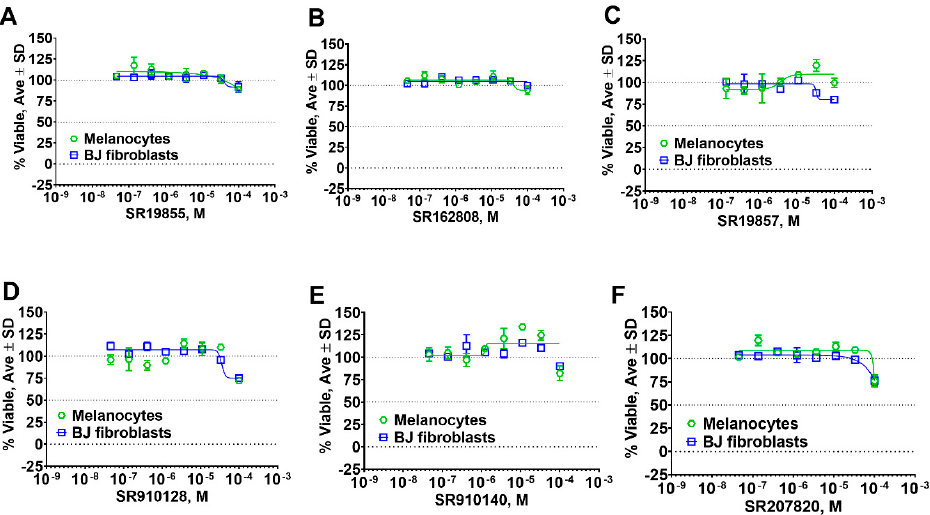
Figure 8. Results of cytotoxicity studies of representative meprin α and meprin β inhibitors. ( A − C ) Meprin α inhibitors. ( D − F ) Meprin β